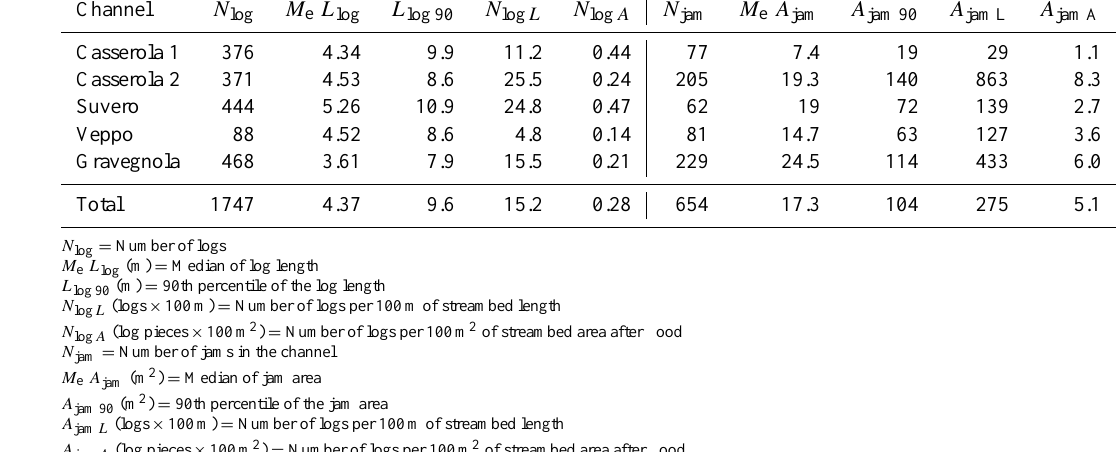
Table 4. LW characteristics (dimensions and spatial density) in the Gravegnola catchment. For symbols see the notation list. Channel N log M e L log L log90 N log L N log A N jam M e A jam A jam90 A jamL A jamA Casserola